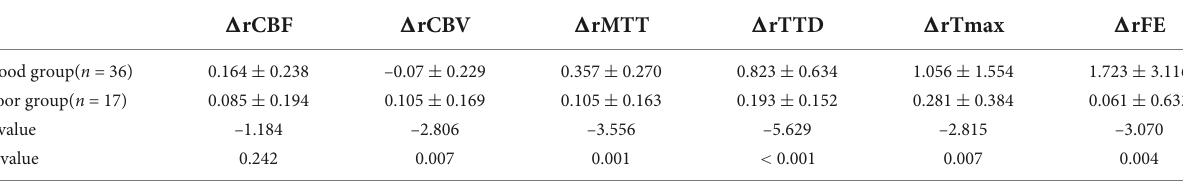
TABLE 3 Comparison of (cid:49) rCTP values before and after operation between good and poor groups.